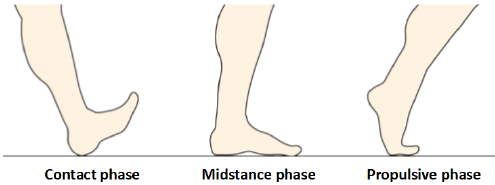
Figure 1. Three different phases during the march.